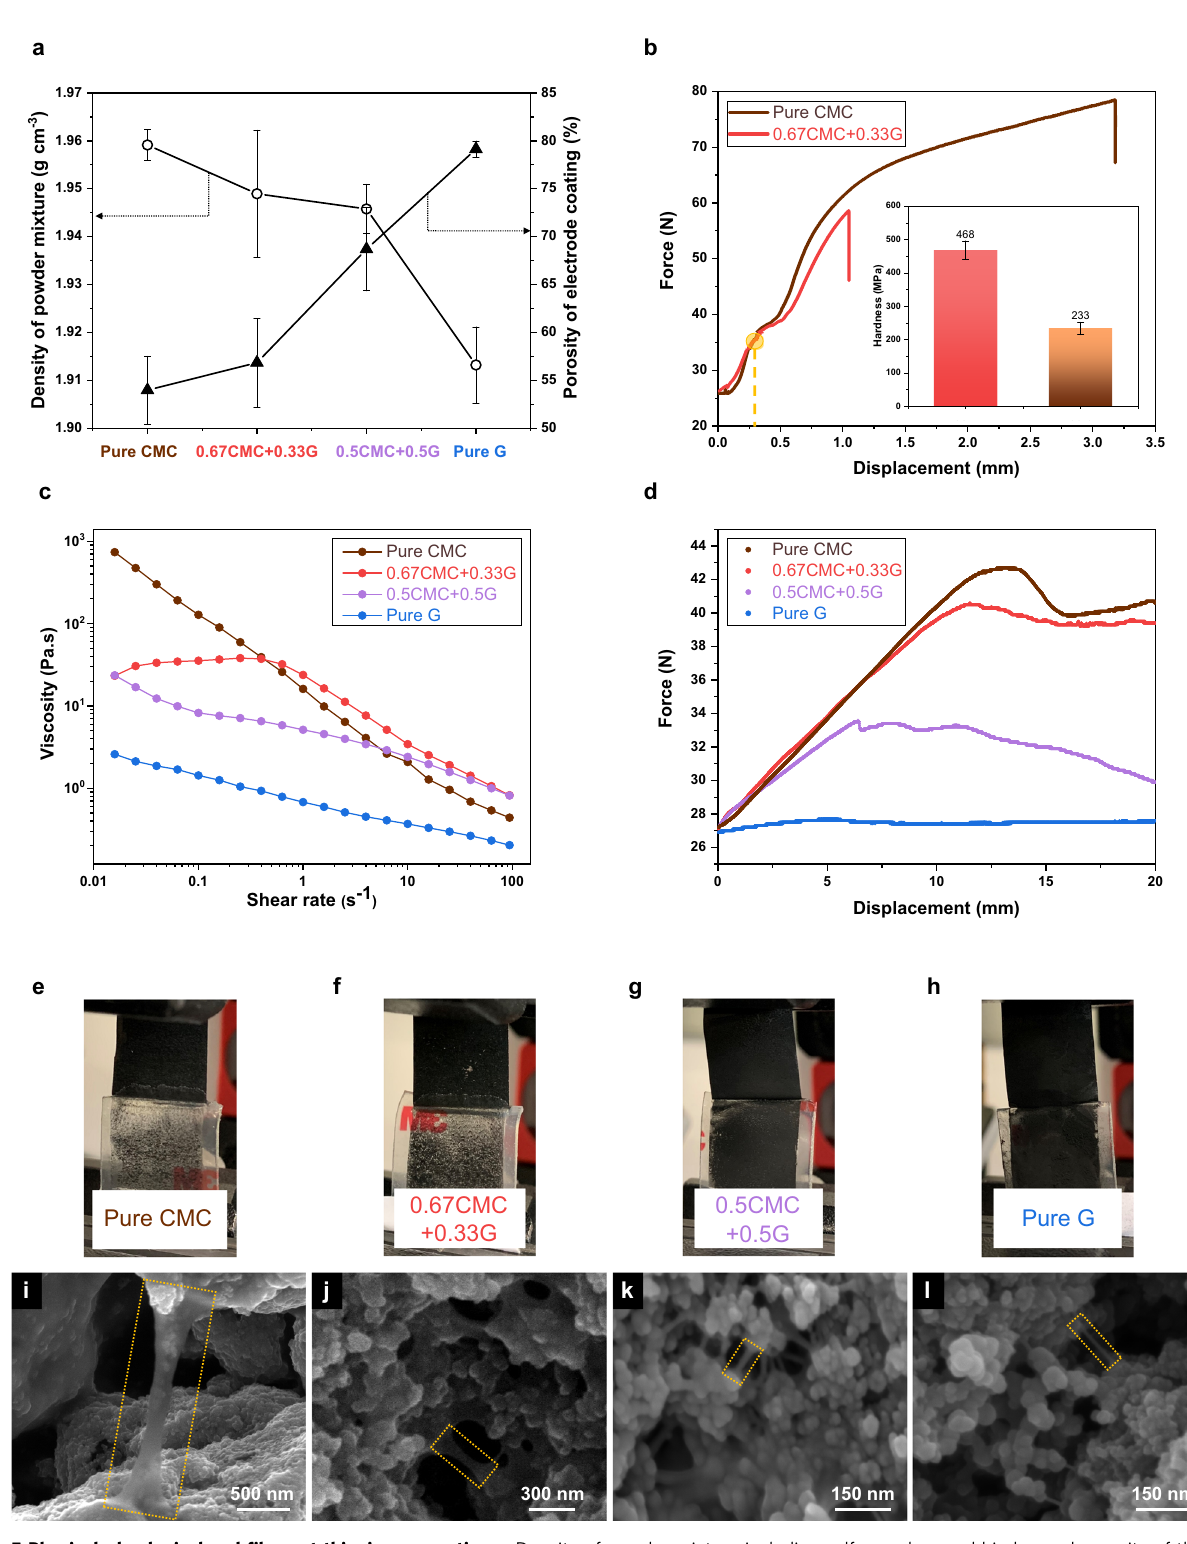
Fig. 5 Physical, rheological and fi lament thinning properties. a Density of powder mixture including sulfur, carbon and binder, and porosity of the fi nal electrode among four different cases. The error bars (standard deviation) of density were calculated based on 10 sets of data and the error bars (standard deviation) of porosity were calculated based on 5 sets of data. b Tensile test and indentation test of cathodes with CMC/G and pure CMC as binder. c Steady-state shear fl ow behaviour. Peeling test d Force versus displacement plots of the peeling test among four samples; e , f Photos of the peeling test setup and i – l microstructures of binder for corresponding samples ( e and i cathodes with pure CMC as binder; f and j cathodes with 0.67CMC + 0.33 G as binder; g and k cathodes with 0.5CMC + 0.5G as binder; h , l cathodes with pure glucose as